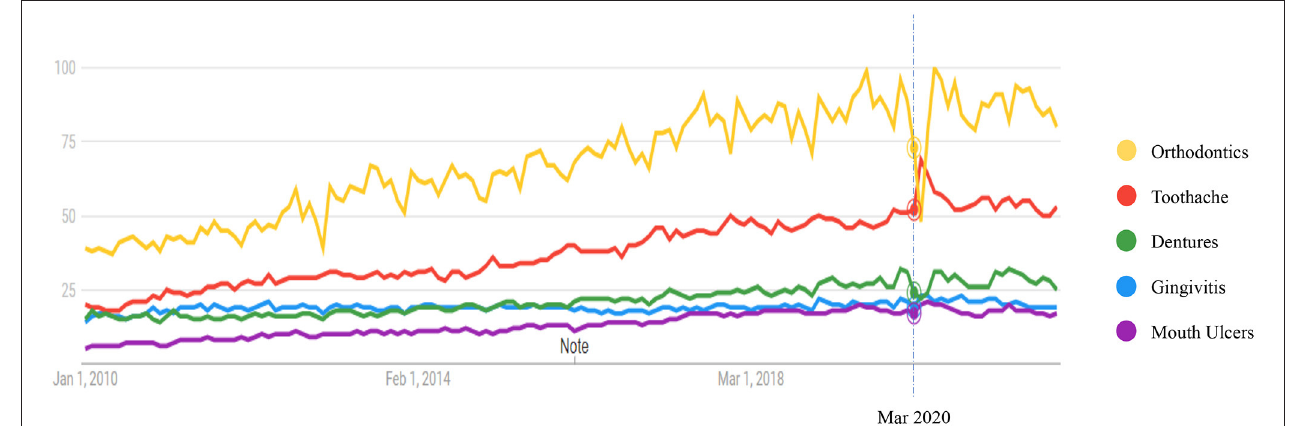
Figure 2 plots the discontinuities of the RSV, conditional on the timing of the COVID-19 mitigation measures. The curves were the averages of the logarithmic value of RSV across bandwidth bins of X to the left and right of the cutoff. The vertical solid lines are the predicted outcomes and associated confidence